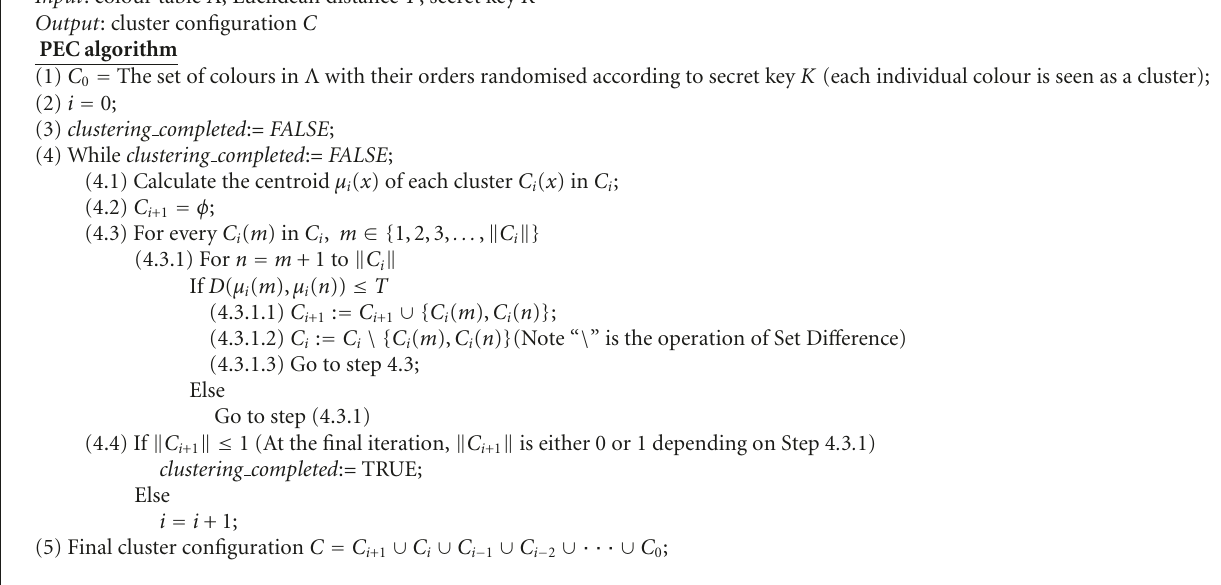
Algorithm 1: Progressive exponential clustering (PEC) algorithm.